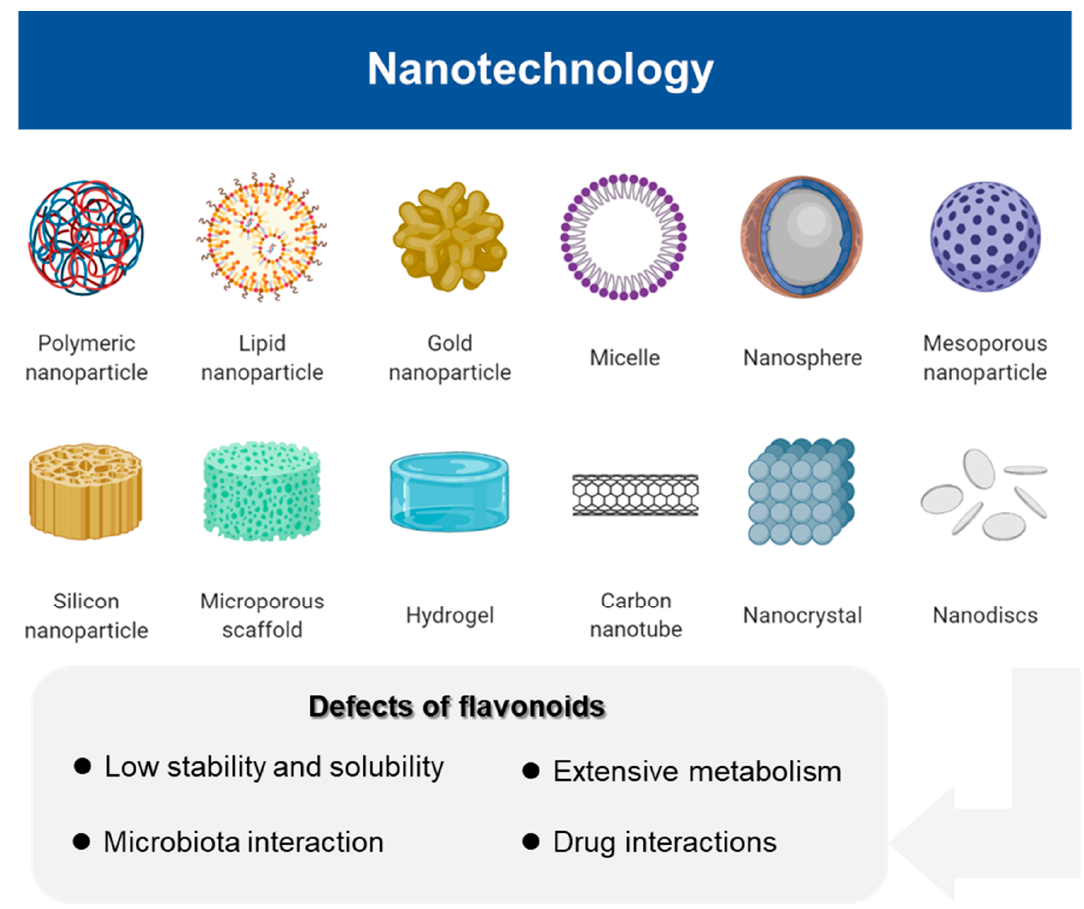
Figure 3. Nanotechnology partially overcomes the defects of flavonoids such as low stability and solubility, extensive metabolism, microbiota interaction, and drug interactions, and further contributes to their effectiveness and drug targeting. This figure was created using BioRender.